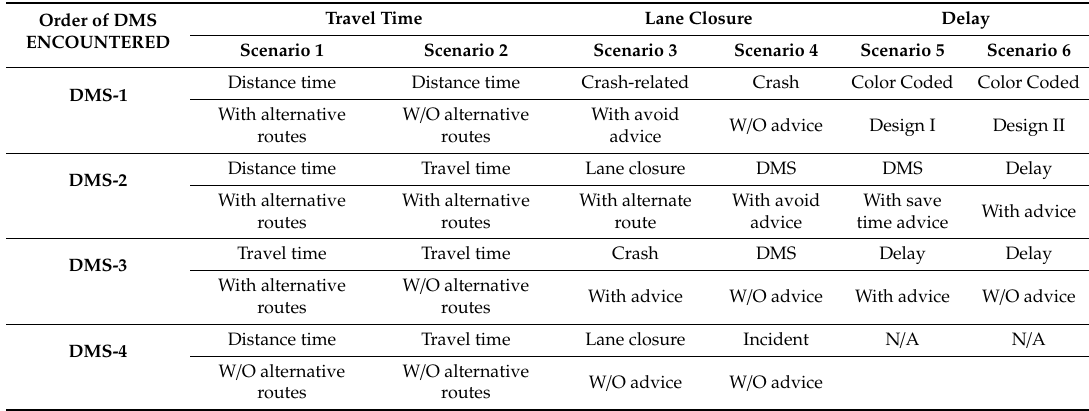
Table 1. Types of DMS signs used in 6